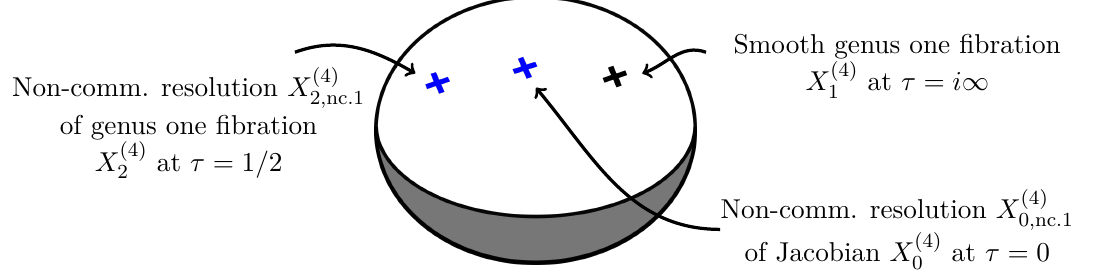
Figure 4 . The stringy Kähler moduli space of generic genus one curves of degree 4 is the modular curve X (4) . For a Calabi-Yau fibration X (4) 1